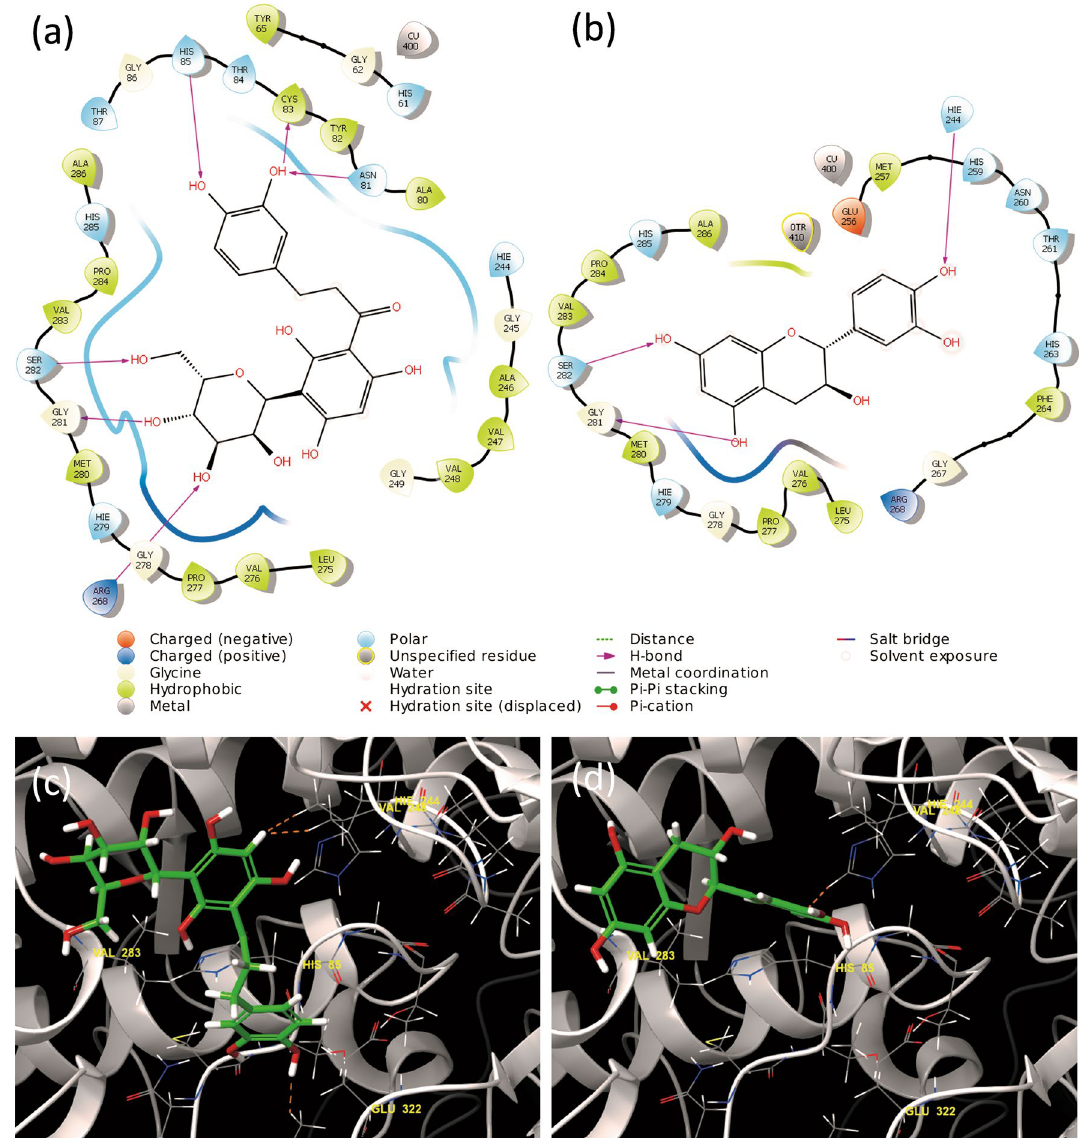
Figure 4. Two- and three-dimensional ligand interaction diagrams of ( a , c ) aspalathin ( 1 ) and ( b , d ) catechin ( 3 ) using the tyrosinase structure (PBD: 2Y9X). The primary bonds formed are hydrogen bonds between aspalathin ( 1 ) and asparagine 81, cysteine 83, histidine 85, serine 292, glycine 291 and arginine 268, and catechin ( 3 ) and histidine 244, serine 282 and glycine 281. Both aspalathin ( 1 ) and catechin ( 3 ) stimulated the tyrosinase enzyme rate in vitro. Hydrogen bonds are represented by orange dashed lines in images ( c ) and ( d ) (https:// www. schro dinger. com/ maest ro; version 12.1.013, release